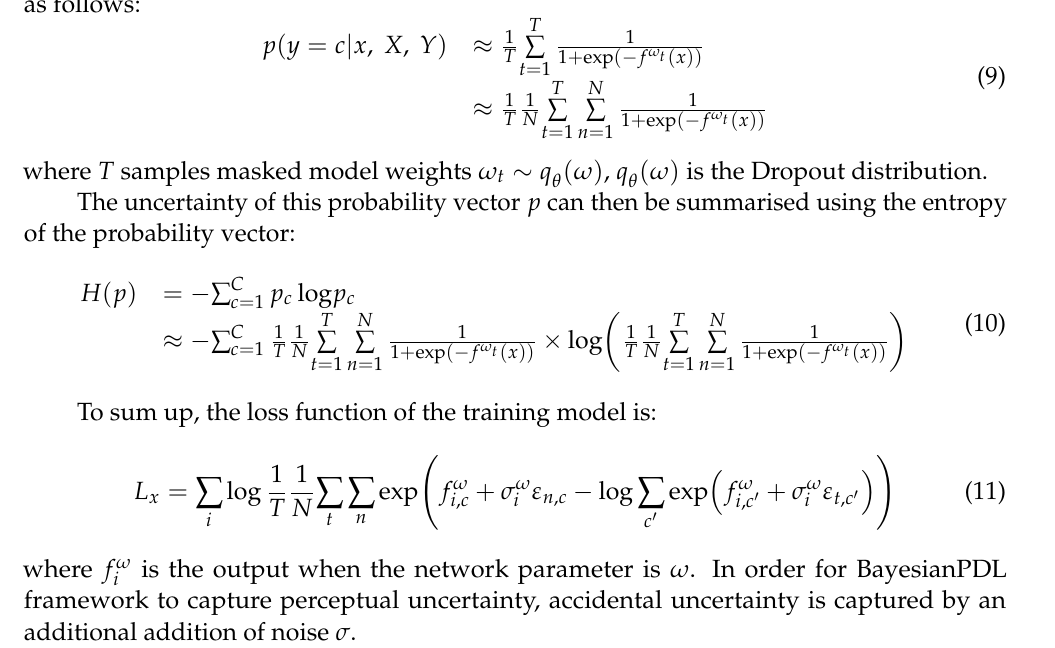
Table 1. Rolling bearing fault dataset.